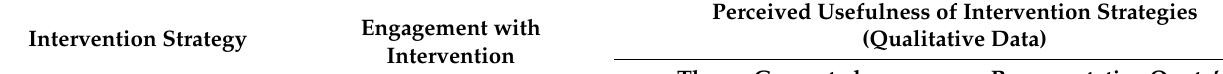
Table 3. Summary of feasibility and acceptability of the intervention